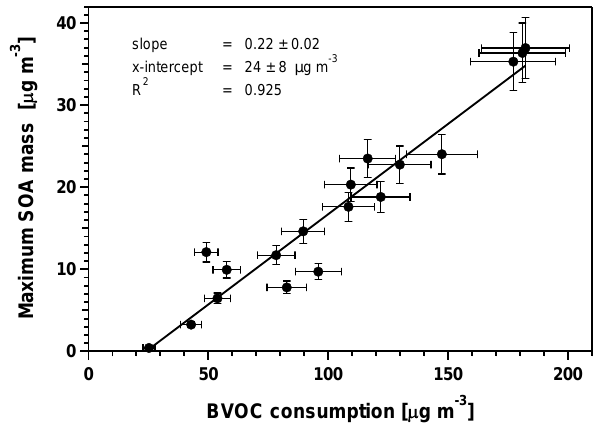
Fig. 2. Maximum BSOA mass produced through OH oxidation of BVOCs emitted from a birch, a pine and a spruce, the lattermost infested by aphids (Experiment #1). The linear regression line in- dicates an incremental yield of 22 ± 2%. The error bars represent relative errors of ± 5% for the SMPS-based BSOA mass and ± 10% for the BVOC consumption according to GC calibration